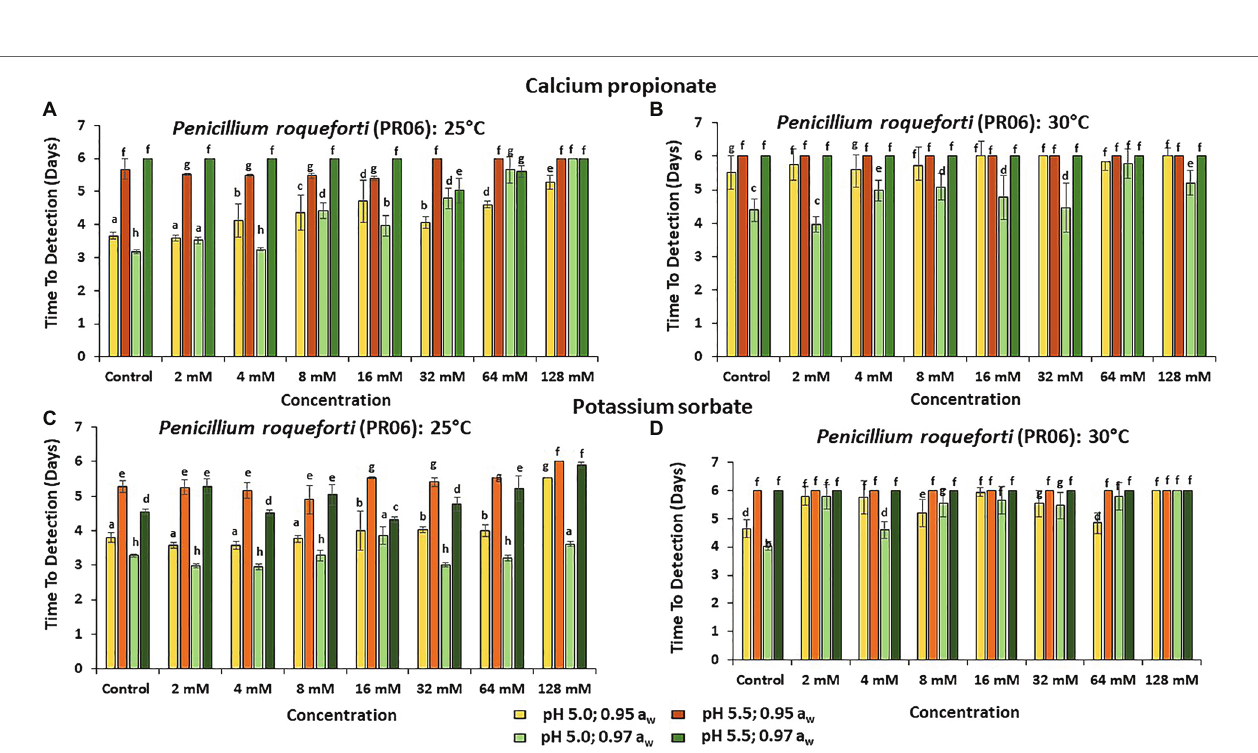
FIGURE 5 | The TTD (OD = 0.4 OD; 6 days) of Penicillium roqueforti (PR06) at (A) 25 ° C and (B) at 30 ° C in the presence of different concentrations of CP; and for PS at (C) 25 ° C and (D) 30 ° C. Bars represent the SEM. Treatments with different letters are significant ( p =